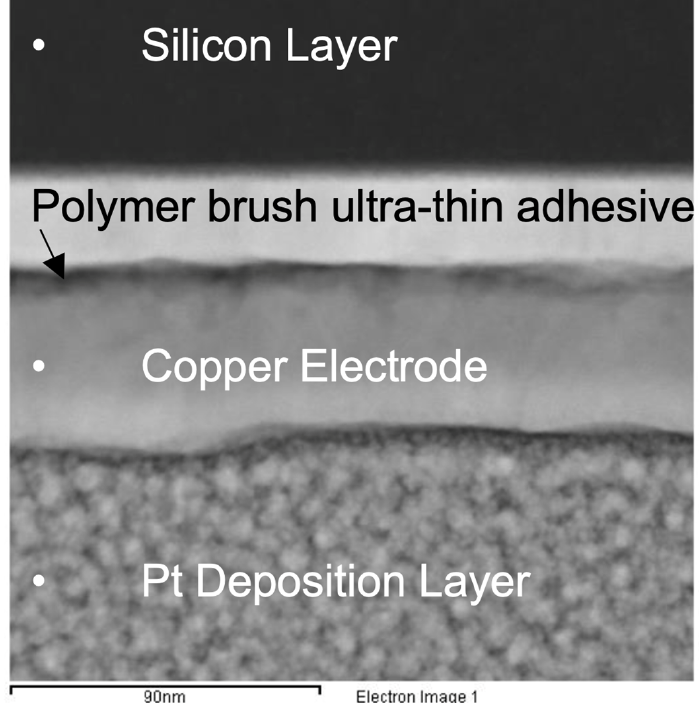
Figure A1. Transmission electron microscopy (TEM) analysis of the chemically fabricated Cu electrode deposited. The chemically prepared Cu electrode was grown on an Au-coated silicon wafer. A Pt deposition layer was then formed by a Ga ion beam milling system (JIB-4501) to protect the Cu metal thin film during the subsequent milling process. A 100-nm-thick sample was then milled by a focused ion beam (FIB) system and detected by TEM.